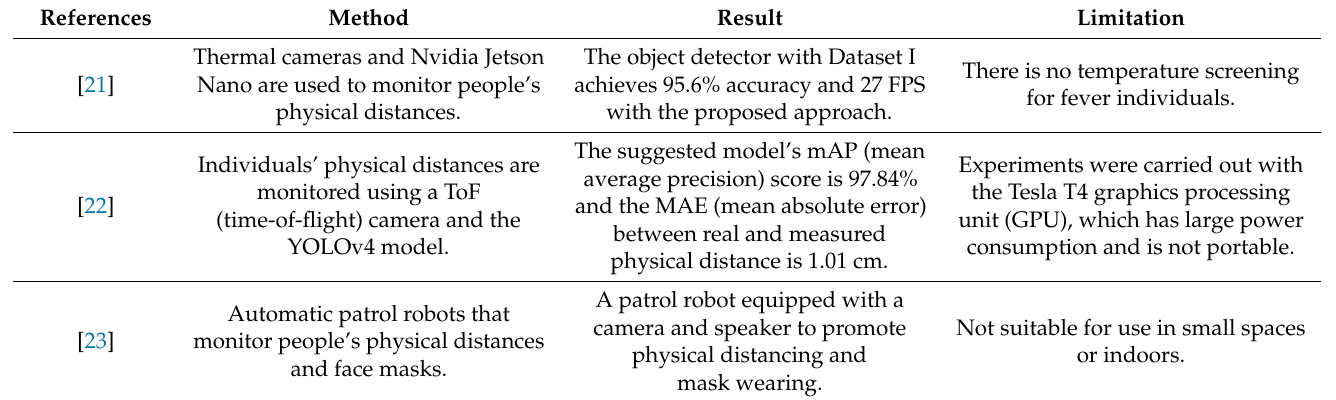
Table 3. Physical distancing solutions based on computer